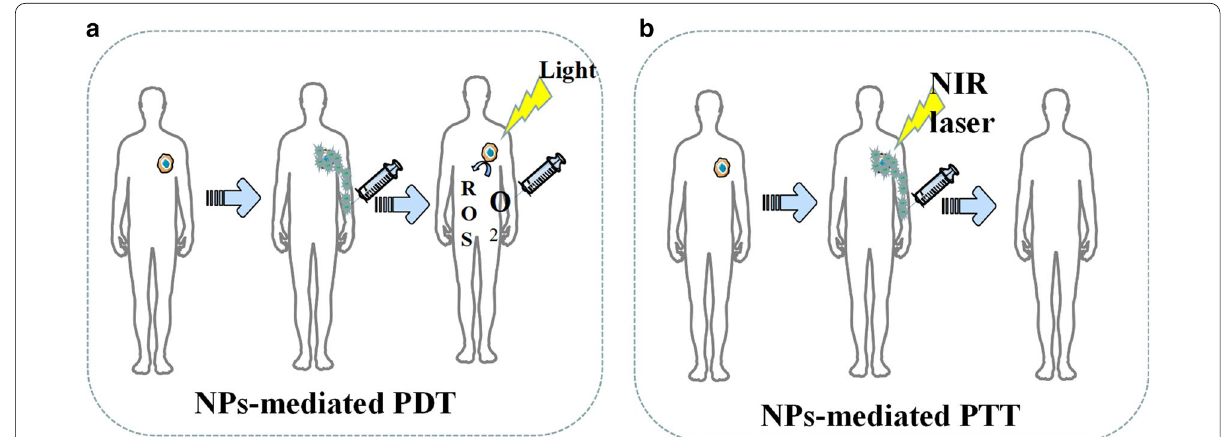
Fig. 6 Diagrammatic illustration of NPs-mediated PDT and PTT. a NPs promote the generation of reactive oxygen. b NPs enhance tumor damage during